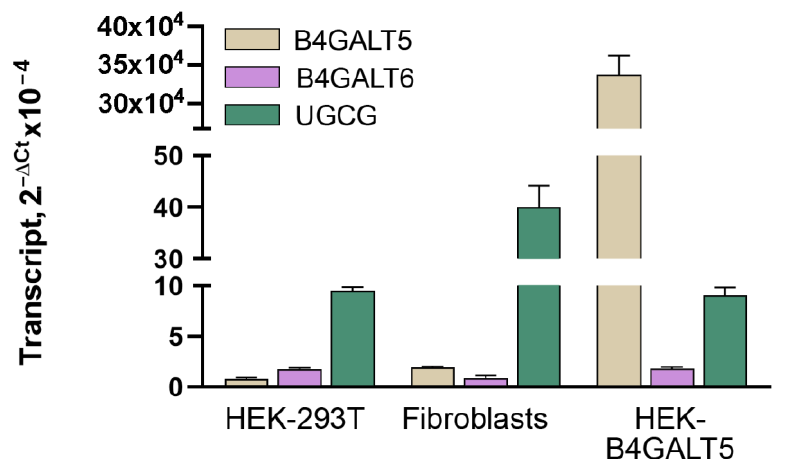
Figure 3. Expression of transcripts coding LacCer synthase in the cells used in this study. Quantitation of RNA transcripts was performed by real-time RT-qPCR. ∆ Ct values were calculated using GAPDH as the reference housekeeping gene.